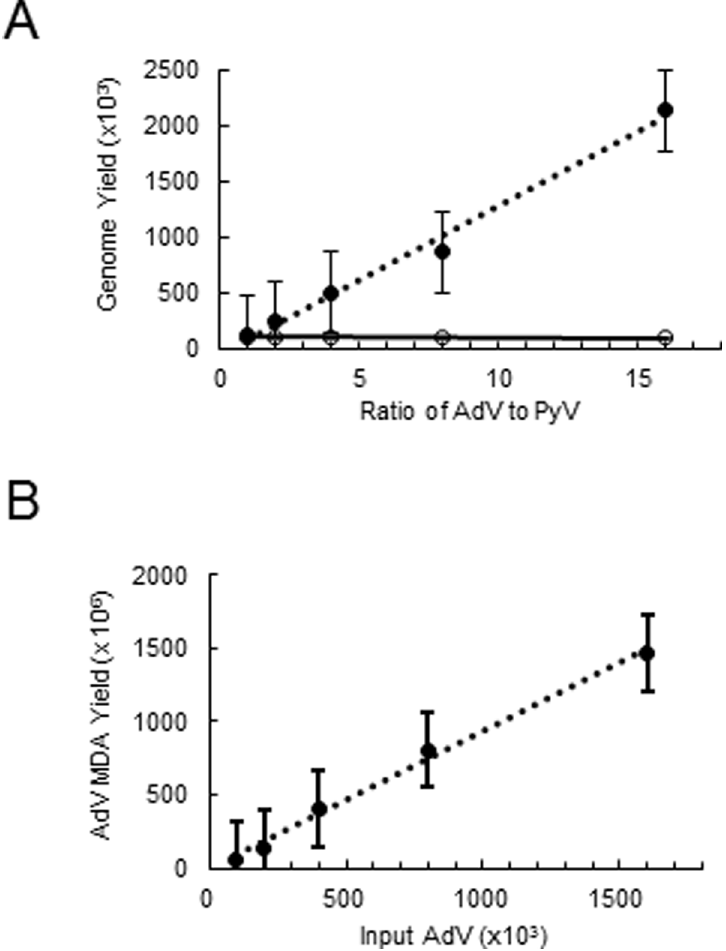
Fig 3. Detection of increasing AdV with a constant amount of PyV, A) before MDA and B) after MDA Symbols: AdV (solid circle), PyV (open circle). Error bars represent standard deviation.